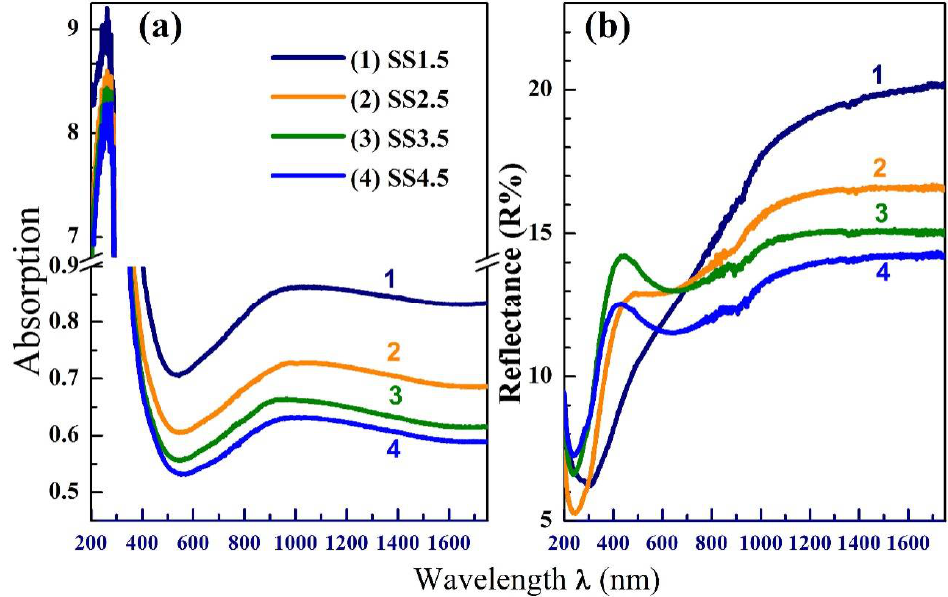
Figure 2. The optical absorbance ( a ) and reflectance spectra ( b ) of the spin-casted films at different